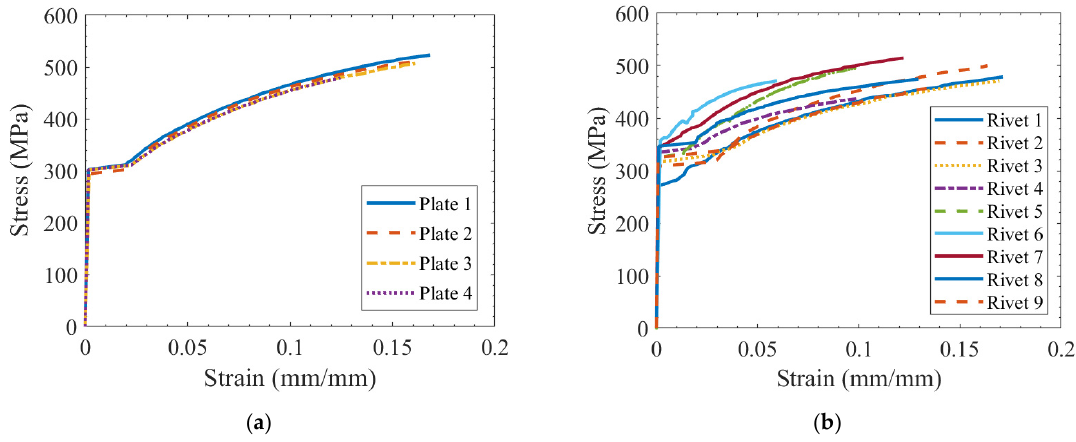
Figure 3. Experimental true stress–strain curves for the ( a ) plate material and ( b ) rivet material. Table 2. Material model parameters (Equation (1)) for plates and rivets. Plate